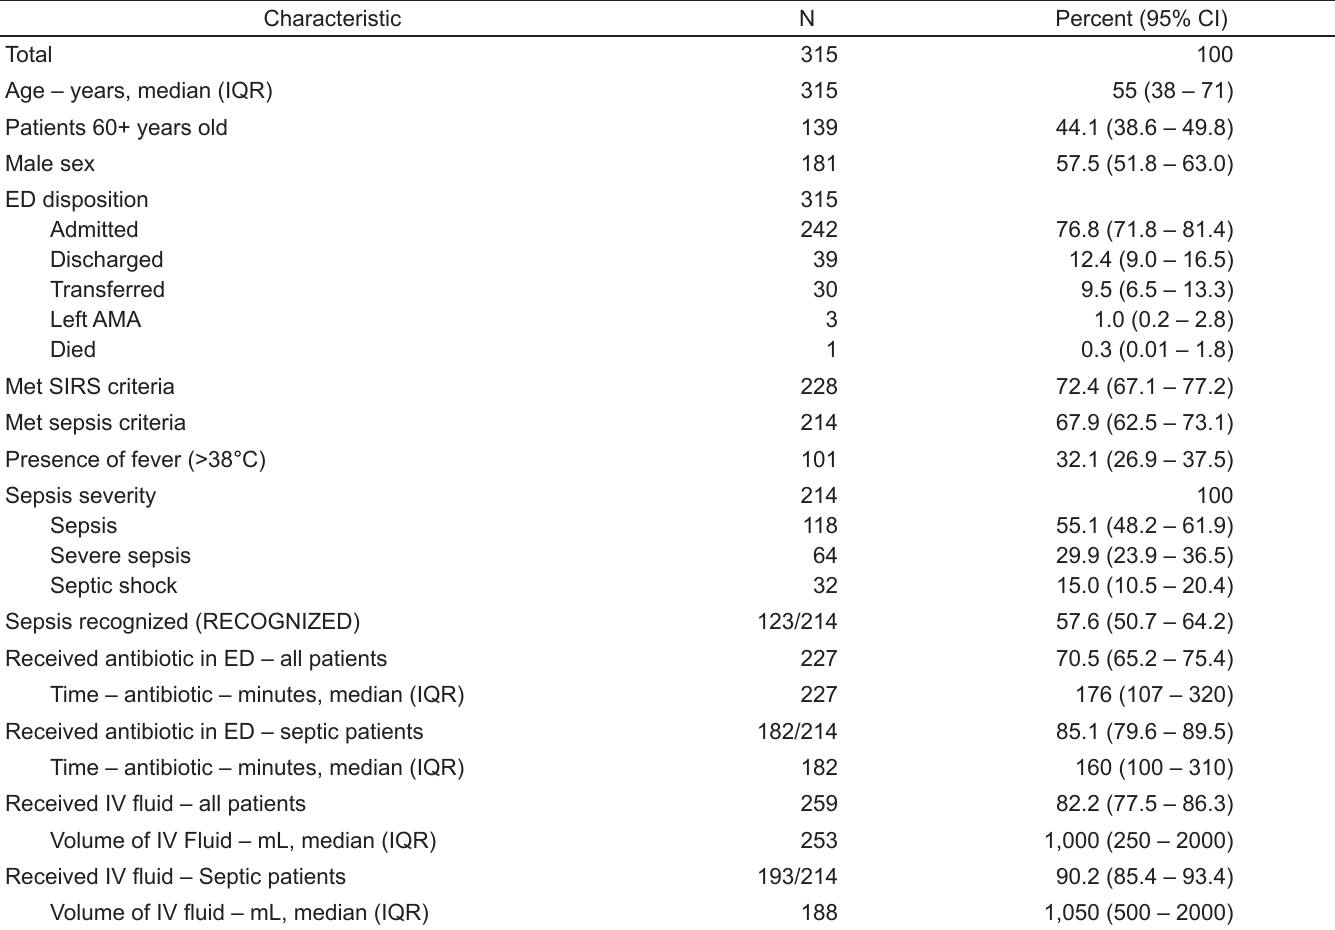
Table 1. Demographics and characteristics of study population of patients who had bacteria cultivated from blood